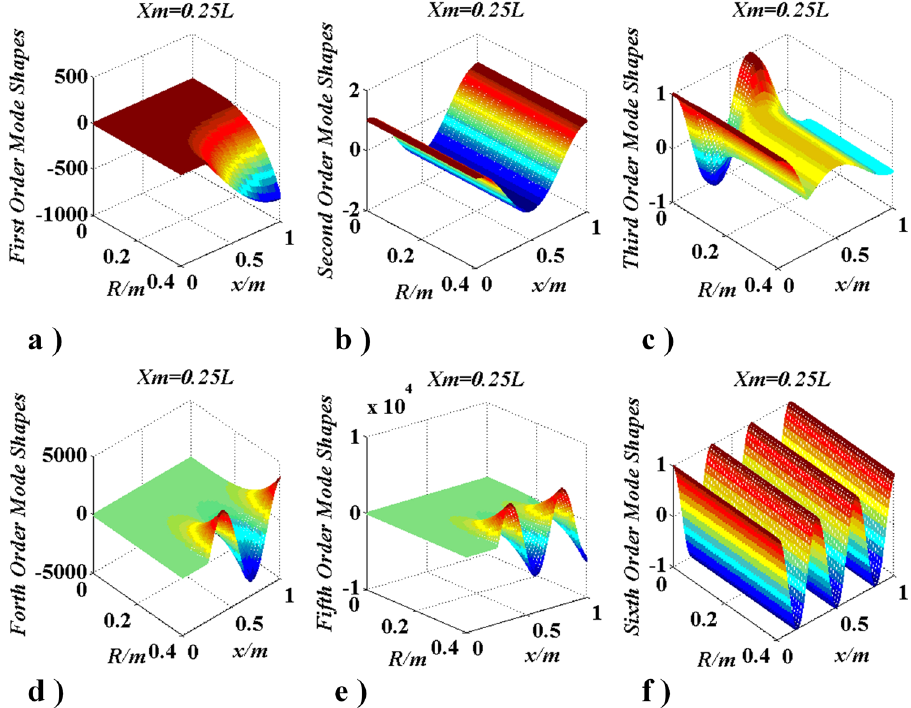
Figure 17. Curves of modes change with R ( J m ) and x m = l